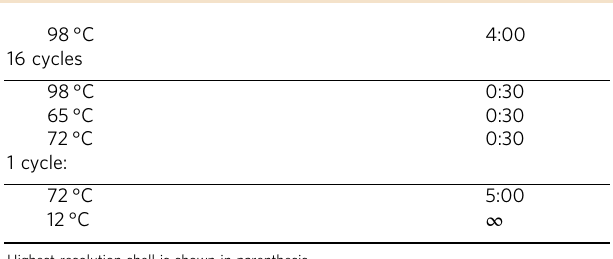
Table 1 Ampli fi cation steps for ChIP-DNA library